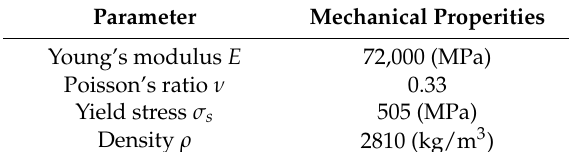
Table 2. Mechanical properties of the material used in the FEM.